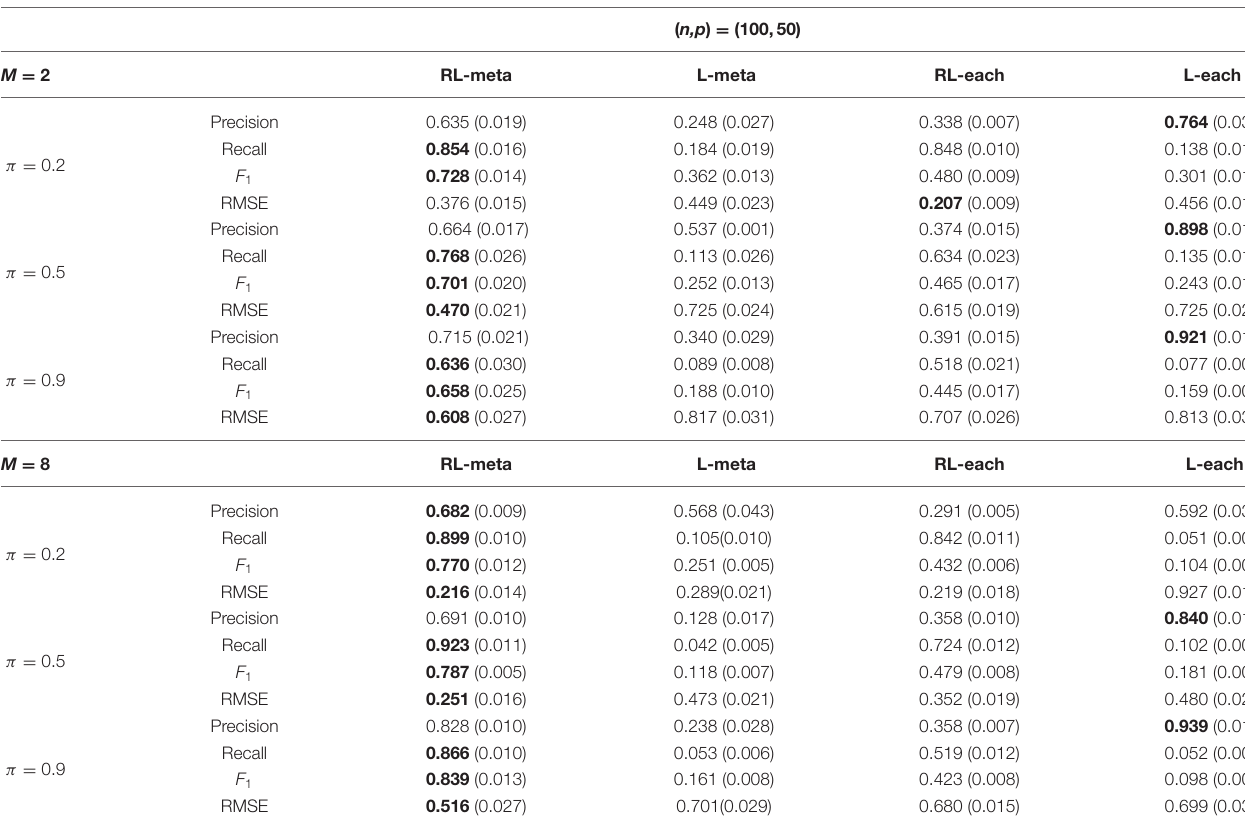
TABLE 3 | Results for low-dimensional data with contamination.